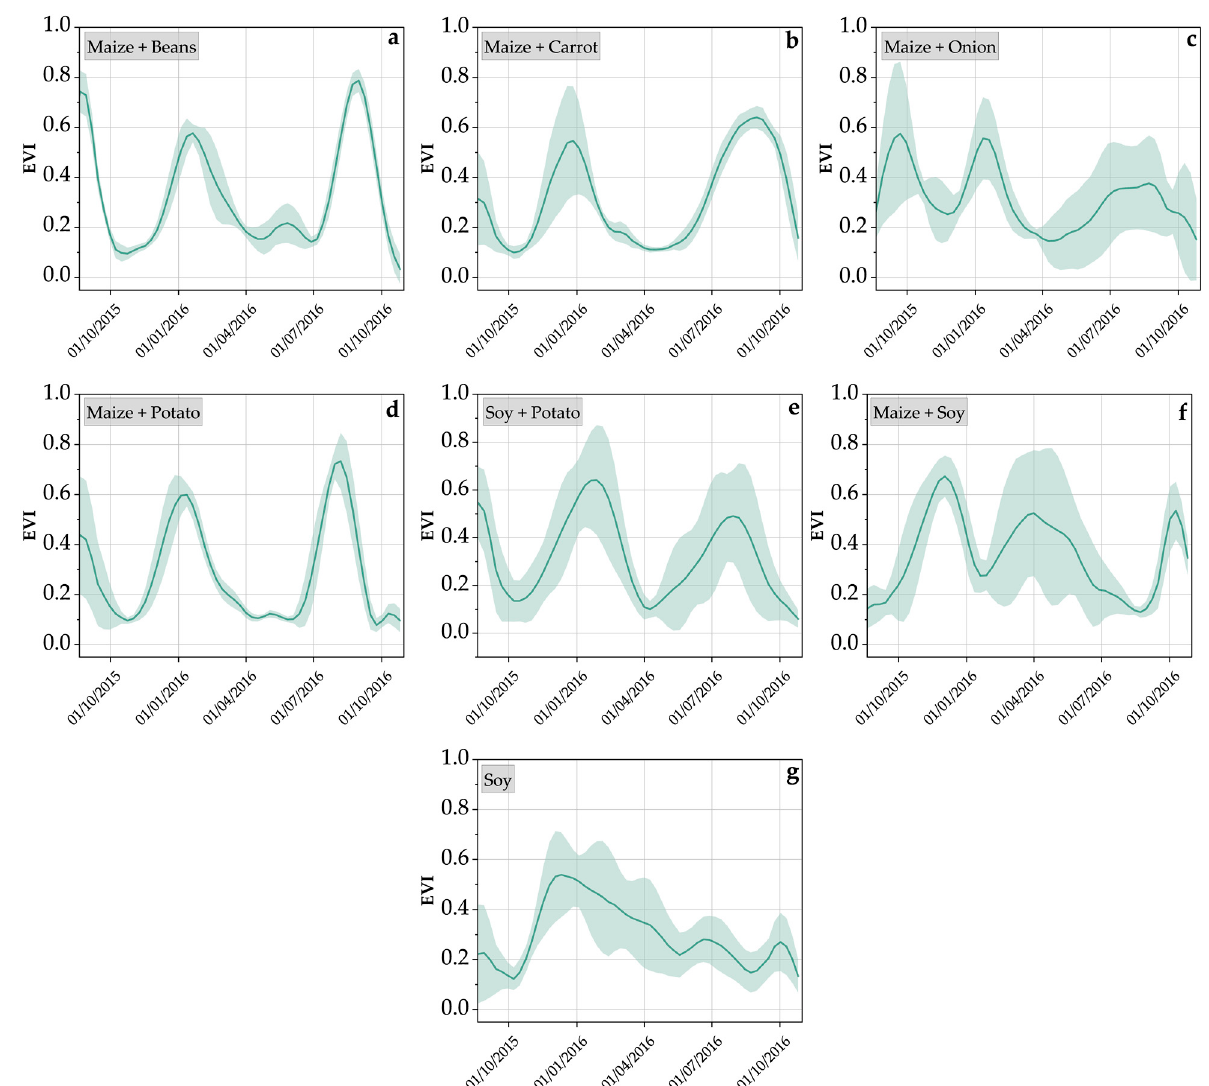
Figure 7. Mean EVI profile with its respective standard deviation for each class in the 2015/2016 agricultural year based on samples collected in the field: ( a – e ) represent the first crop + winter crop type, ( f ) represents the first crop + second crop class, and ( g ) shows the single crop type.